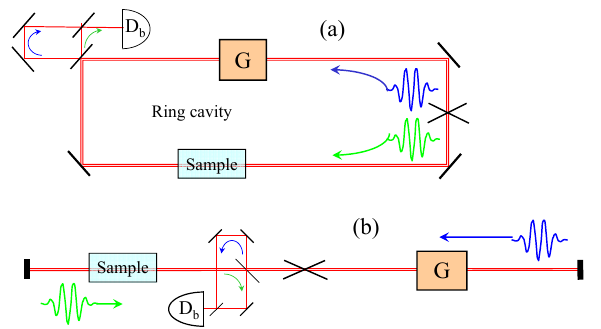
Figure 1. Idealized design of an intracavity phase interferometer, in a ring ( a ) or linear ( b ) configura- tion. Two pulses (green and blue) are circulated in the cavity. Sample is a device that produces, at each round-trip, a differential phase shift between the two pulses that is proportional to the quantity to be measured. This phase difference results in an optical frequency difference. The latter is measured as a beat note between the two output combs made to interfere via an optical delay line on a detector D b . G is the gain